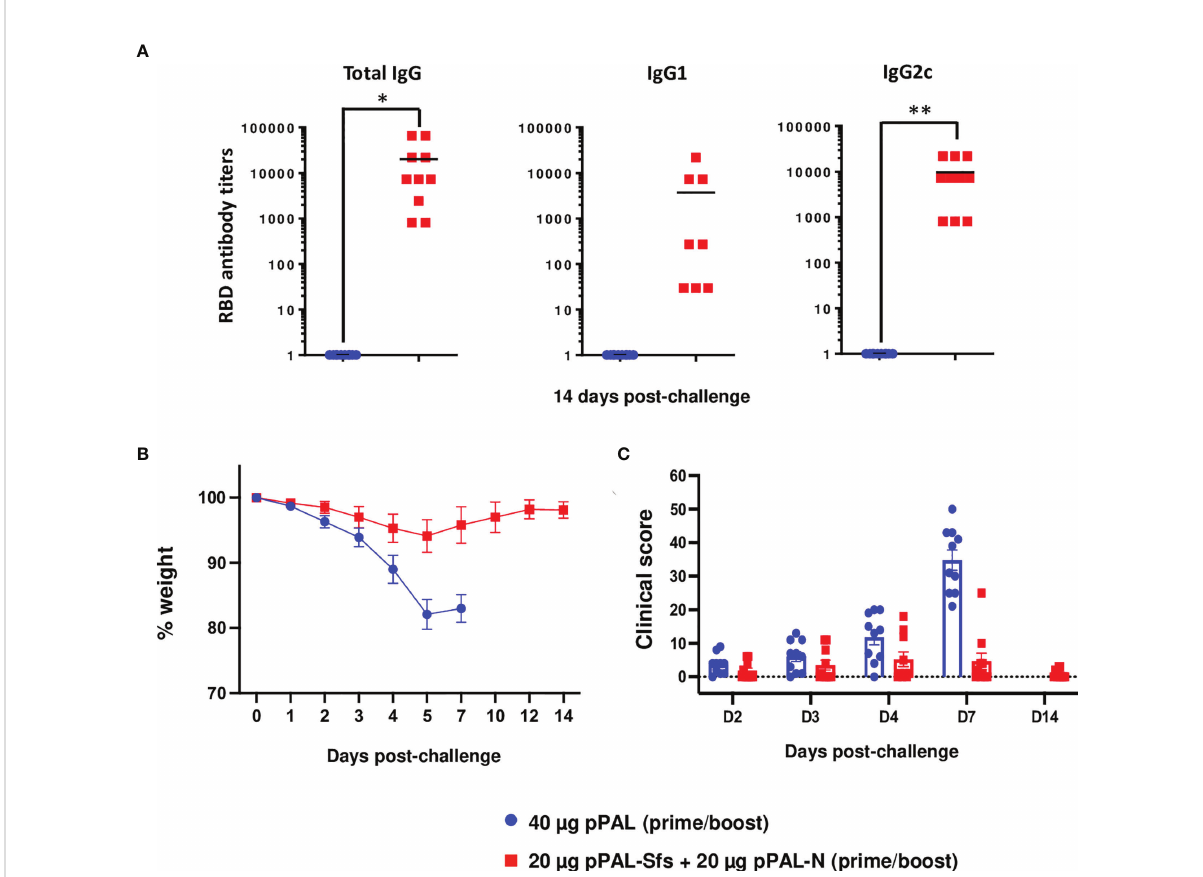
FIGURE 7 Full protection of K18-hACE2 mice after three months of vaccination with pPAL-Sfs+ pPAL-N against challenge with 10 5 PFU of the MAD6 SARS-CoV-2 isolate in the K18-hACE2 murine model. (A) Titration of circulating anti-RBD IgG, IgG1, and IgG2c three months after the pPAL-Sfs + pPAL-N booster dose administration. (B) Body weight evolution after 10 5 PFU SARS-CoV-2 challenge. Vaccinated animals maintained their weight throughout the experiment, whereas weight decreased in the control group. (C) Clinical sign follow-up after challenge with 10 5